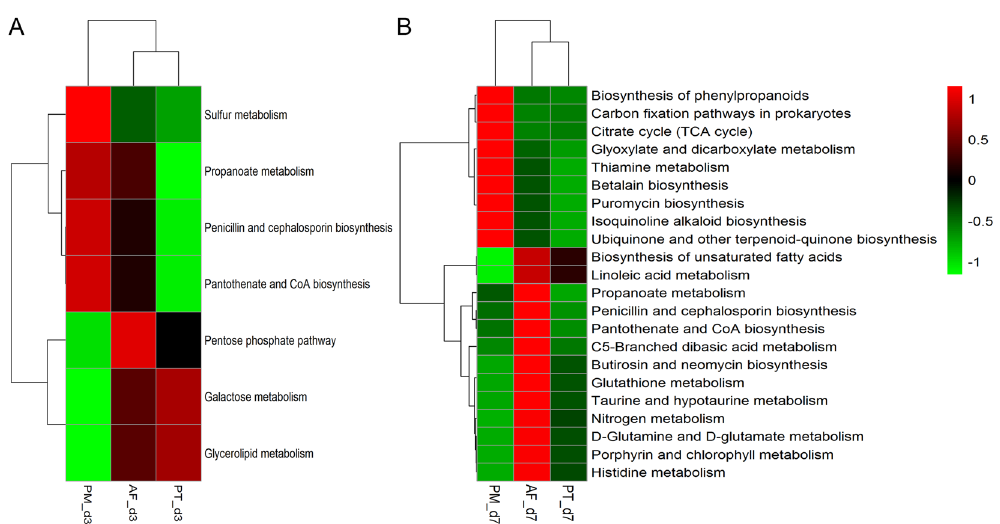
Figure 6. Heatmap of significantly different metabolic pathways of the three study groups on d3 ( A ) and d7 ( B ). One-way ANOVA test was used for the comparison of metabolic pathways among the three groups (P < 0.05). The cluster analysis was based on the processes of metabolism. The activity score (AS) calculated by Pathway Activity Profiling (PAPi) ranged from − 1 to 1. For the abbreviation of group names, see Fig. 1